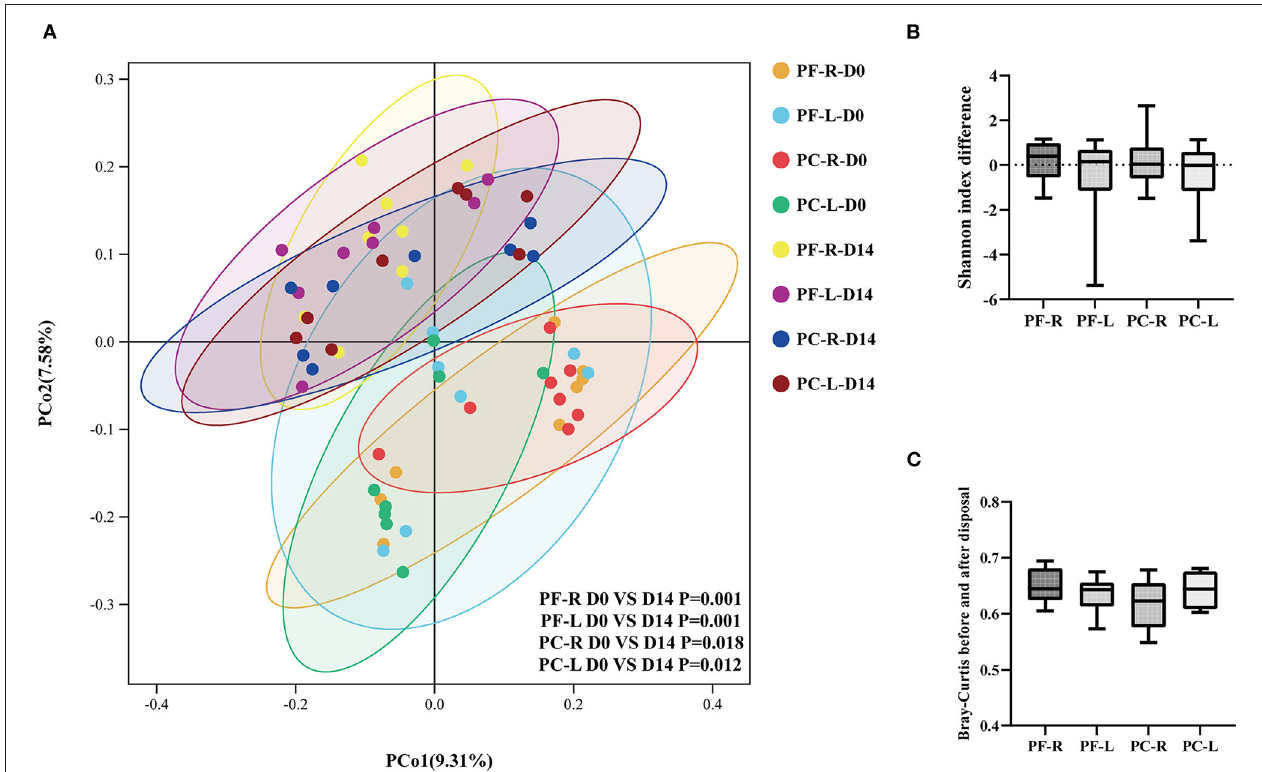
FIGURE 4 | Alpha and beta diversity analysis within the individuals and between the preservative-free (PF) and preservative-containing (PC) groups. (A) The PCoA plot based on the unweighted UniFrac distance index. (B) The differences in Shannon index between the repeated samples in each group. (C) Bray-Curtis indices between the repeated samples in different